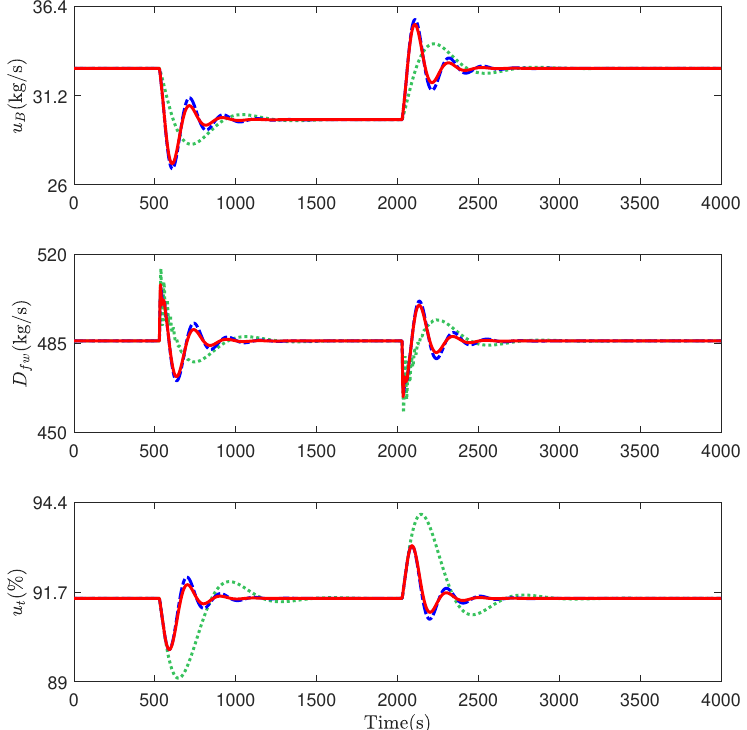
Figure 11. Disturbance rejection of the supercritical CFB unit under unknown fuel